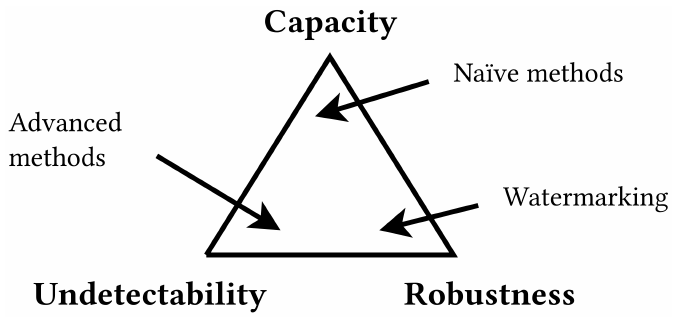
Figure 1. Relationship between steganography